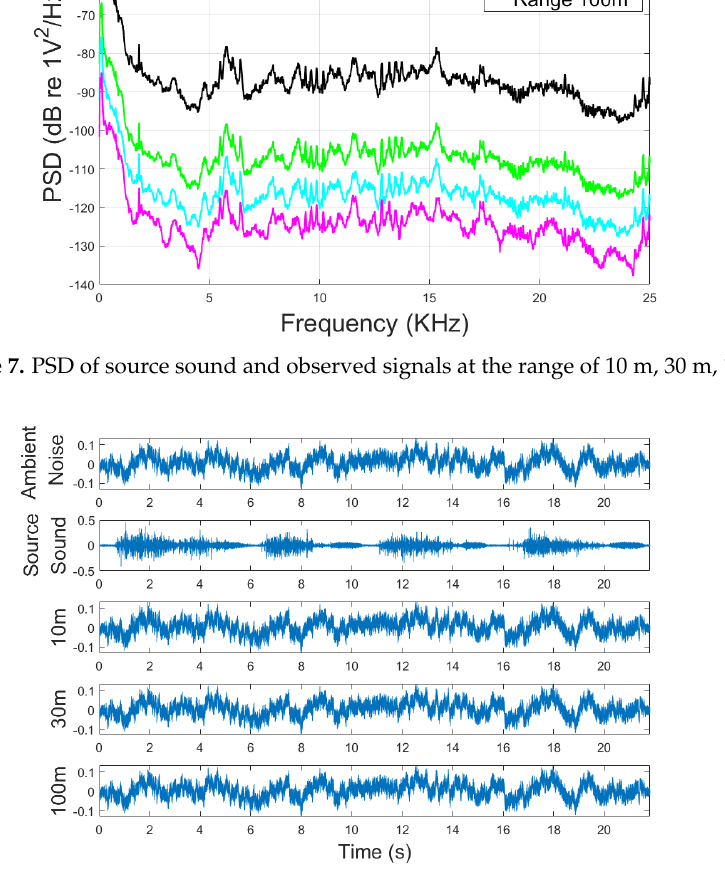
Figure 8. Ambient noise, source sound and observed signals at the range of 10 m, 30 m, 50 m.